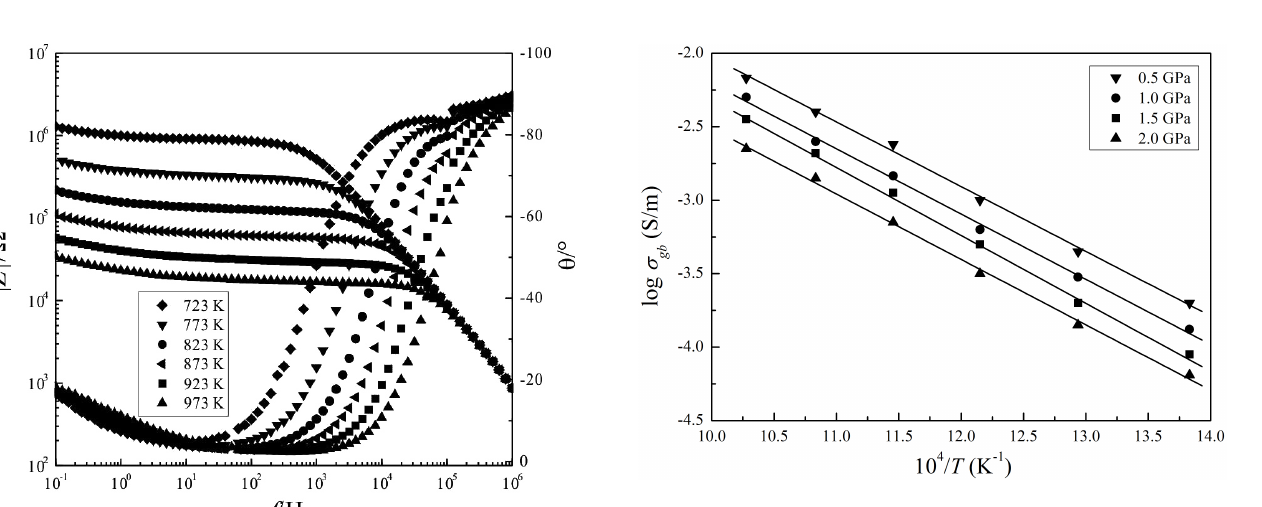
Figure 4. The relationship of the logarithmic grain boundary conductivity vs. reciprocal temperature under conditions of 0.5– 2.0GPa and 723–973K.